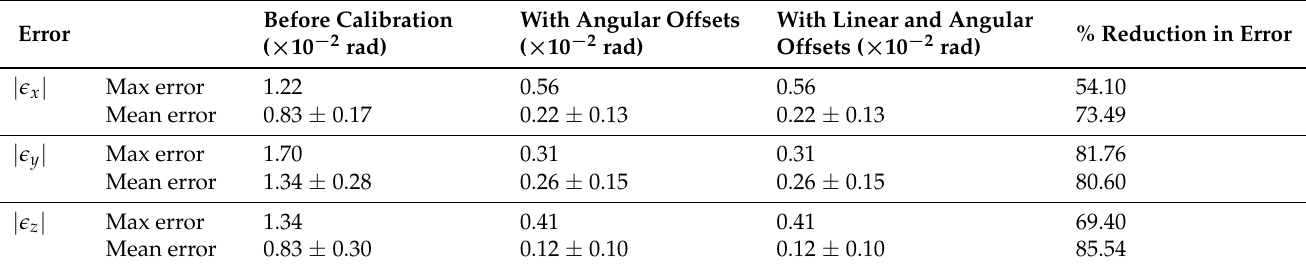
Table 12. Resultant orientation error before and after calibration.